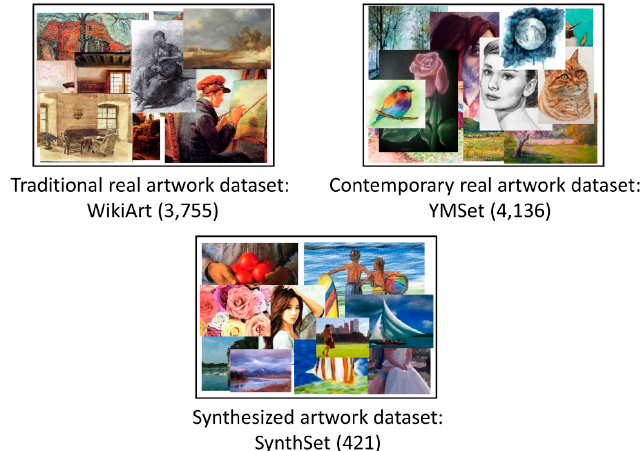
Figure 3. Three datasets for our approach.